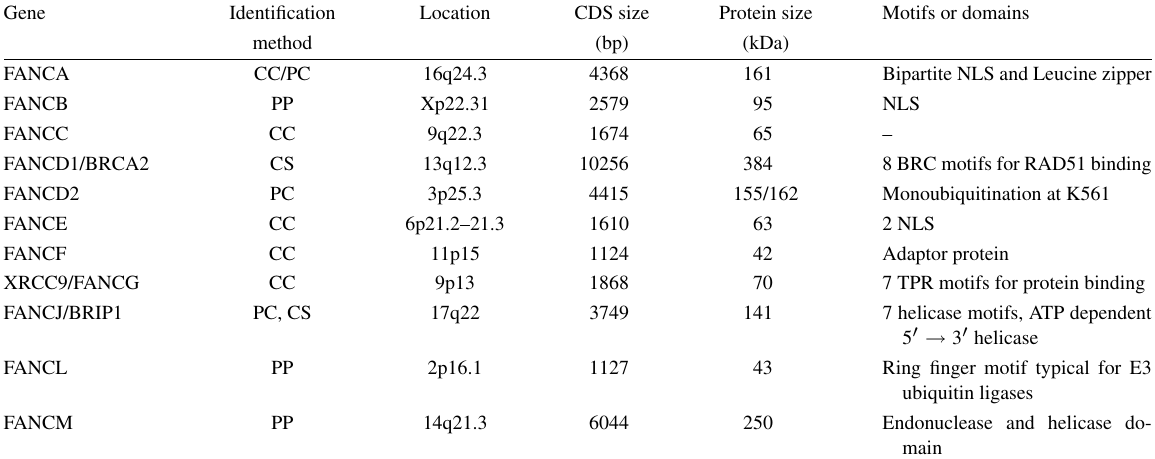
Characteristics of all currently known FA genes and